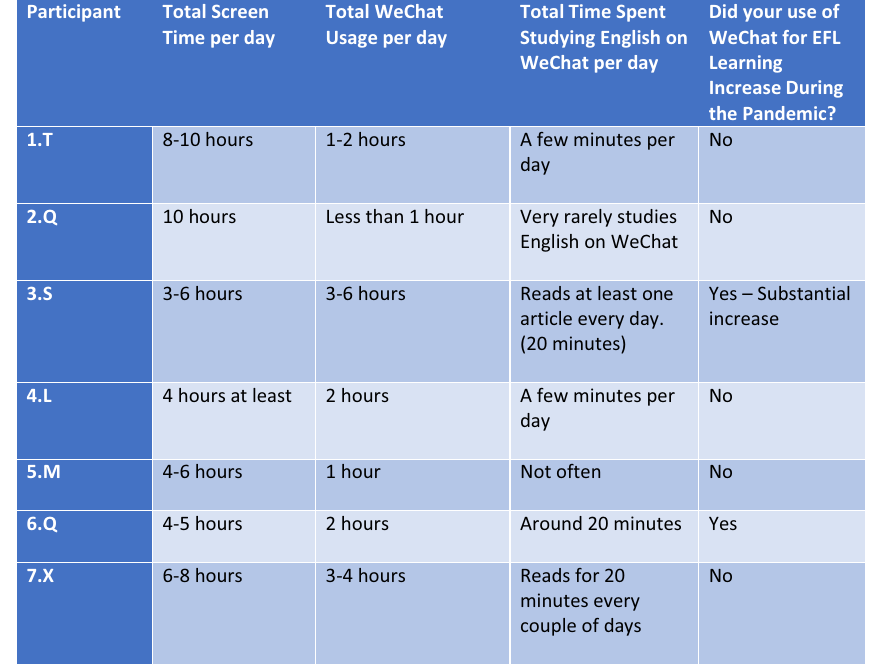
Fig. 3 WeChat usage